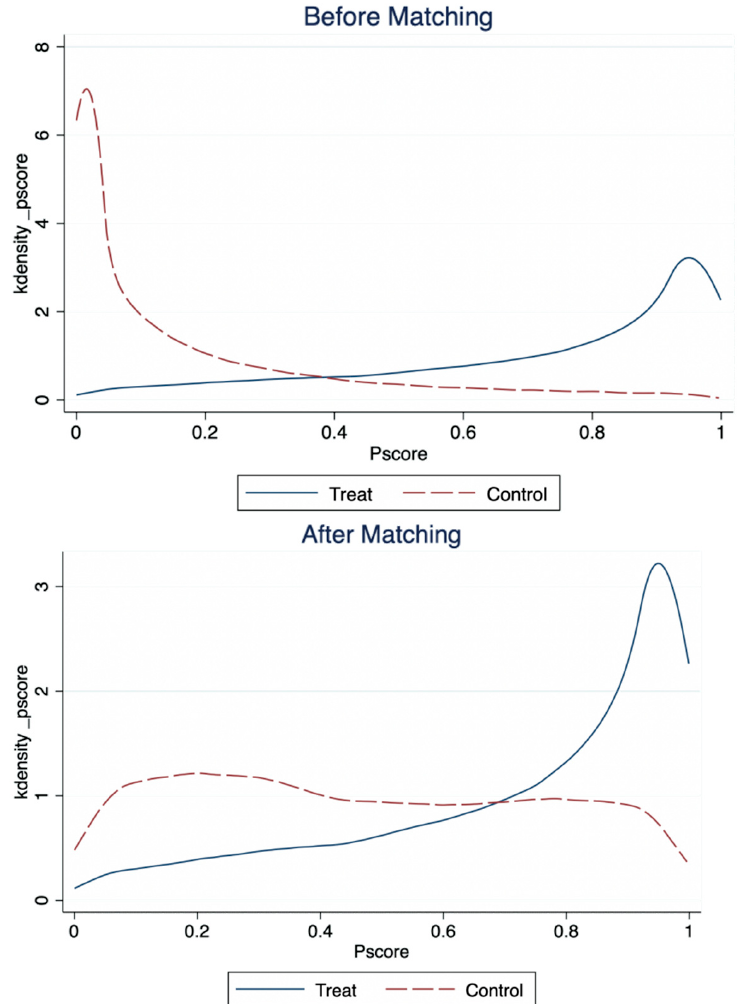
Figure 4. Fit Plot of Propensity Score Before and After Matching.